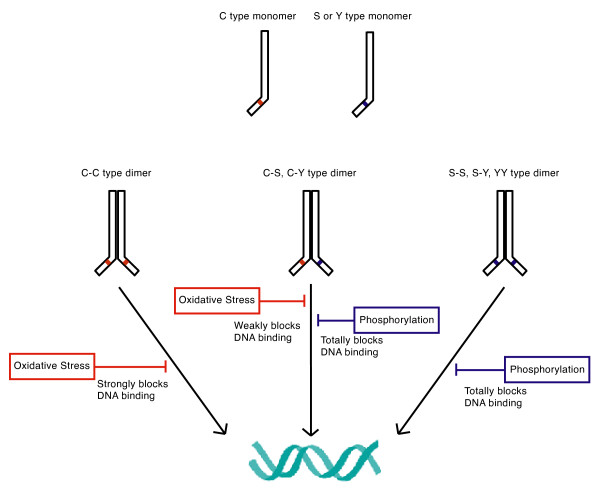
Representation of the phosphorylation and redox control of DNA binding in bZIP dimers. Red-dotted monomers contain C19, whereas blue-dotted monomers contain either S19 or Y19. C-C type dimers are very sensitive to oxidative stress and cannot bind to DNA under these conditions. C-S and C-Y dimers are moderately sensitive to oxidative stress. Furthermore, C-S and C-Y dimers can be phosphorylated at S19 or Y19 to totally abolish DNA binding. S-S and S-Y dimers also totally abolish DNA binding when phosphorylated at any of the S19 or Y19 residues. Phosphorylation behaves dominantly. To simplify the graph, we excluded A19 monomers and dimers. A-A type dimers are neither controlled by redox nor by phosphorylation. S-A type dimers are controlled by phosphorylation. No C-A or Y-A type dimers have been observed, see [19].